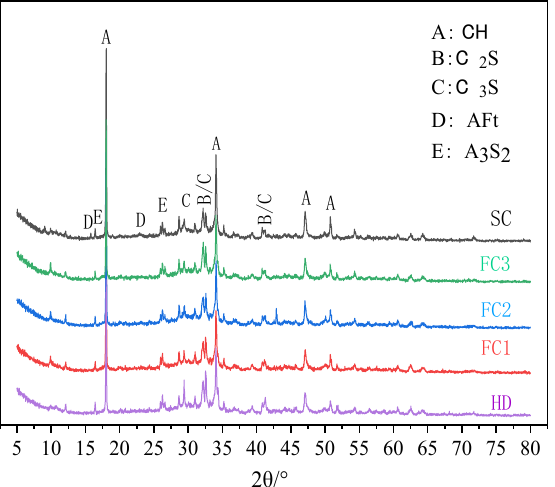
Figure 14. The XRD patterns of FA25-P under different curing systems.